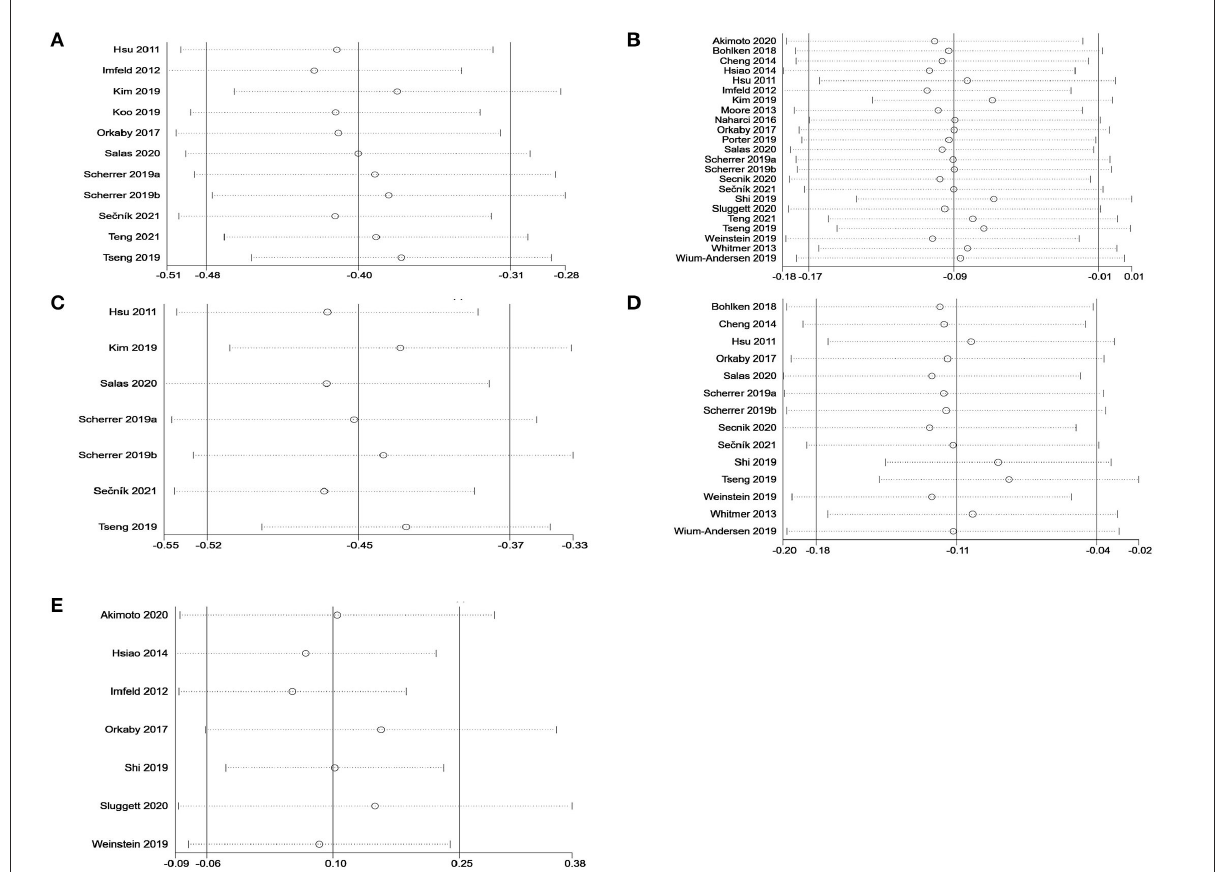
FIGURE5 Sensitivity analysis of metformin on cognitive dysfunction in patients with diabetes in a random-effects meta-analysis of included observational studies. (A) All studies (unadjusted covariates); (B) All studies (adjusted covariates); (C) Subgroup meta-analysis on dementia (unadjusted covariates); (D) Subgroup meta-analysis on dementia (adjusted covariates); (E) Subgroup meta-analysis on AD (adjusted